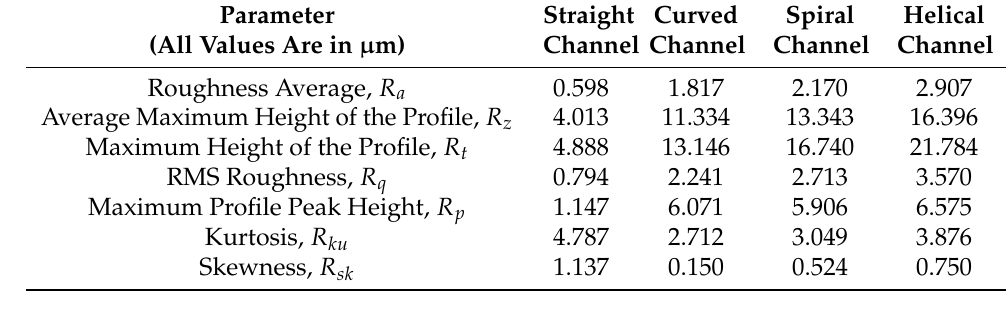
Table 3. Surface roughness profile parameters.